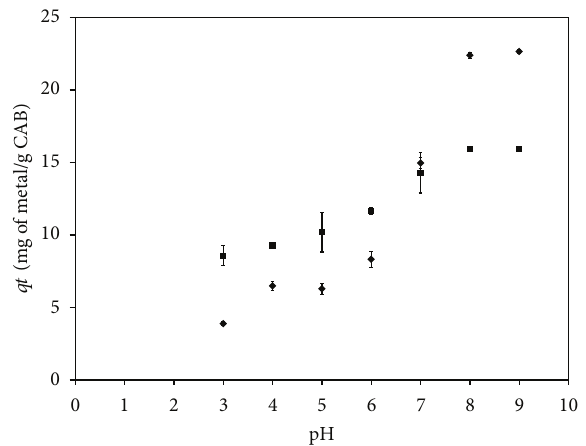
Figure 5: Influence of pH on the biosorption of Cd ( X ) and Pb ( ◼ ) by